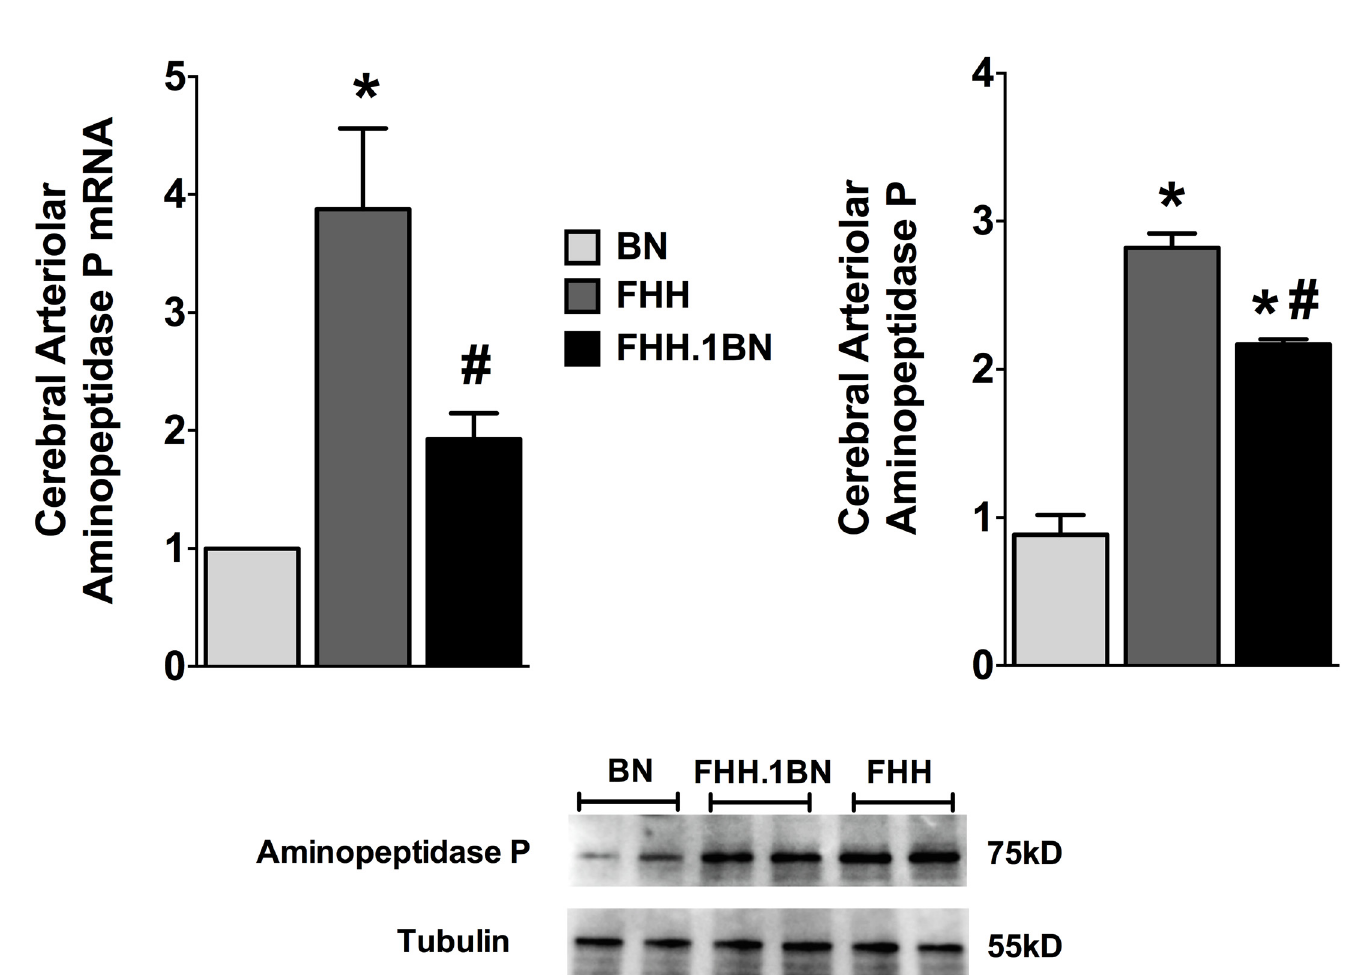
Fig 2. Cerebral arterial aminopeptidase P expression. Cerebral arteriolar aminopeptidase P mRNA and protein expression in different experimental groups. Values are mean ± S.E.M., * P < 0.05. vs. BN and #P < 0.05. vs. FHH, n = 6.